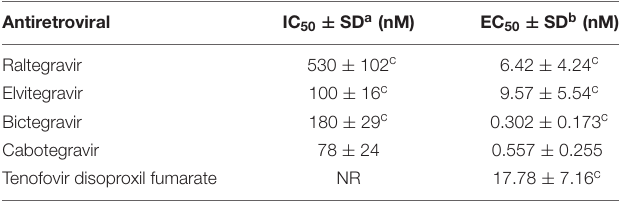
TABLE 1 | Calculated parameters of in vitro HTLV-1 IN strand-transfer and HTLV-1 infection inhibition by INSTIs and one NRTI. Antiretroviral